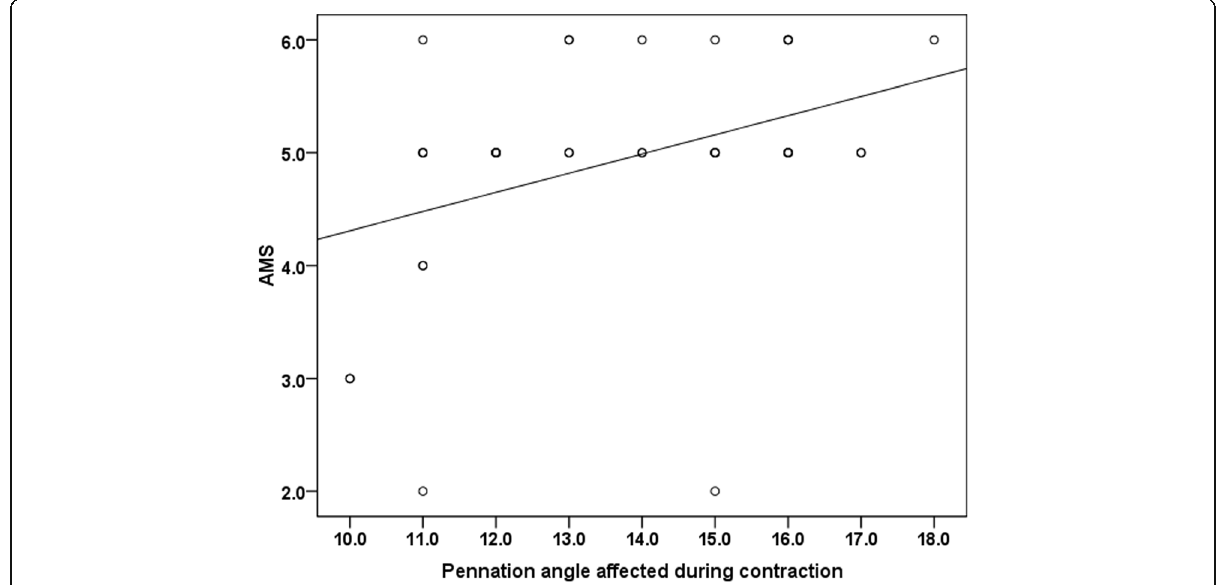
Fig. 8 Correlation between AMS and pennation angle in the affected side during contraction ( r = 0.390; P =